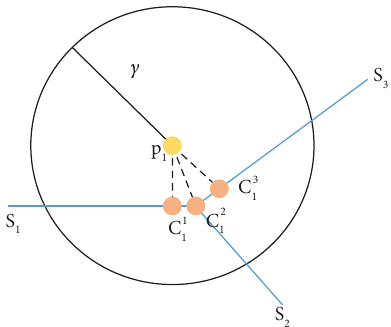
Figure 4: Candidate subroad segments and candidate points of trajectory point.